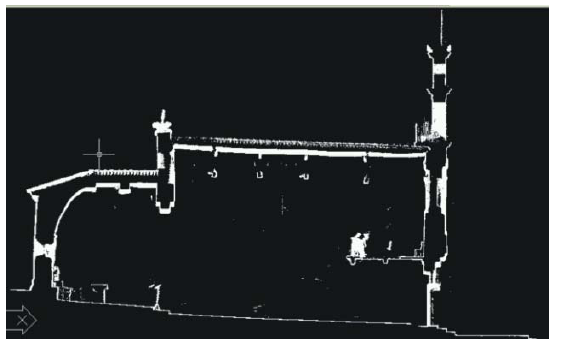
Figure 6. Section of floor plan in a CAD system Moreover, figure 7 and figure 8 show another cross section in a side view (E-W) as exported by Laser Scanning software and CAD quotation, respectively